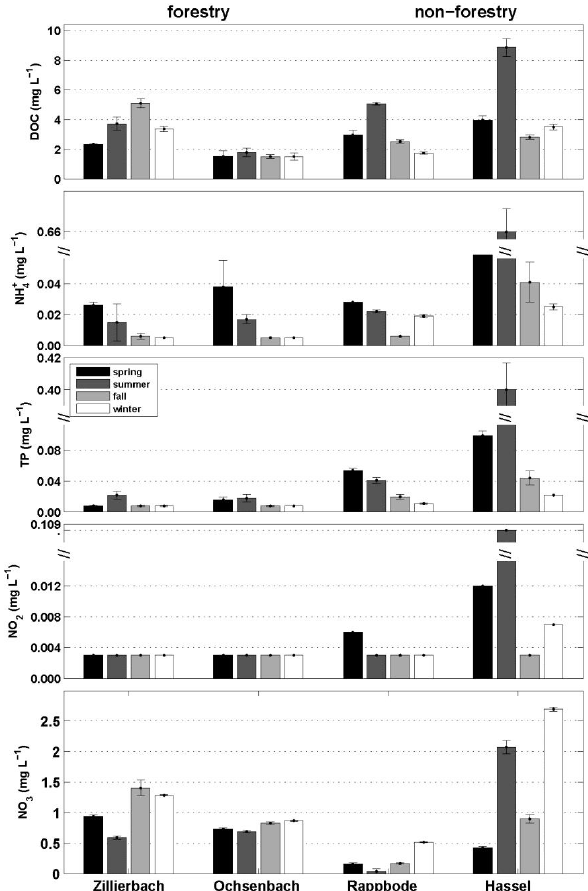
Fig. 3. Overview of the chemical characteristics of the inves- tigated streams. The presented values are mean values ( ± SD) of the chemical data measured during each field campaign. Following parameters are shown: DOC=dissolved organic car- bon, NH + =ammonium, TP=total phosphorus, NO 2 =nitrite and 4 NO 3 =nitrate.